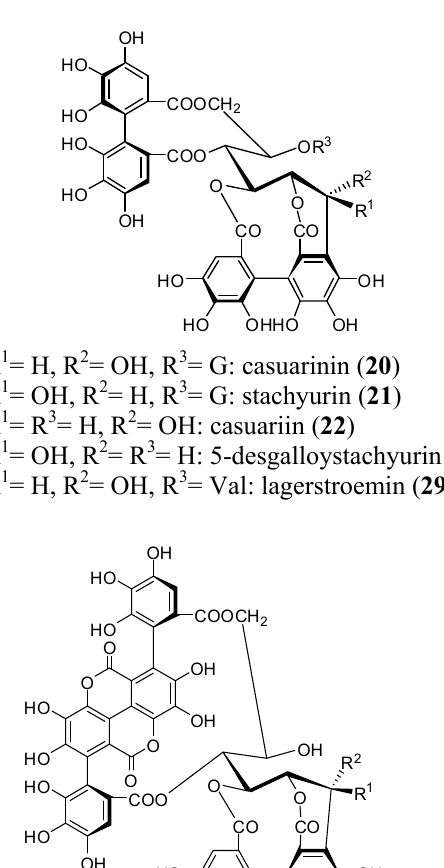
Figure 2. Structures of C -glycosidic ellagitannins 16 – 29